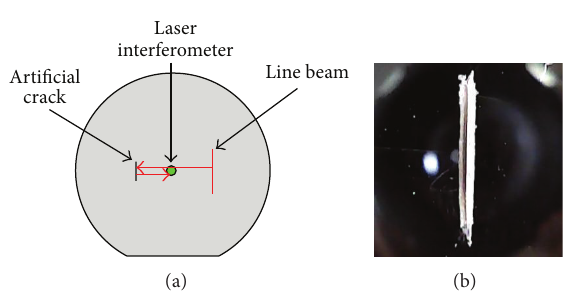
Figure 8: (a) Reflection method schematic and (b) artificial crack.